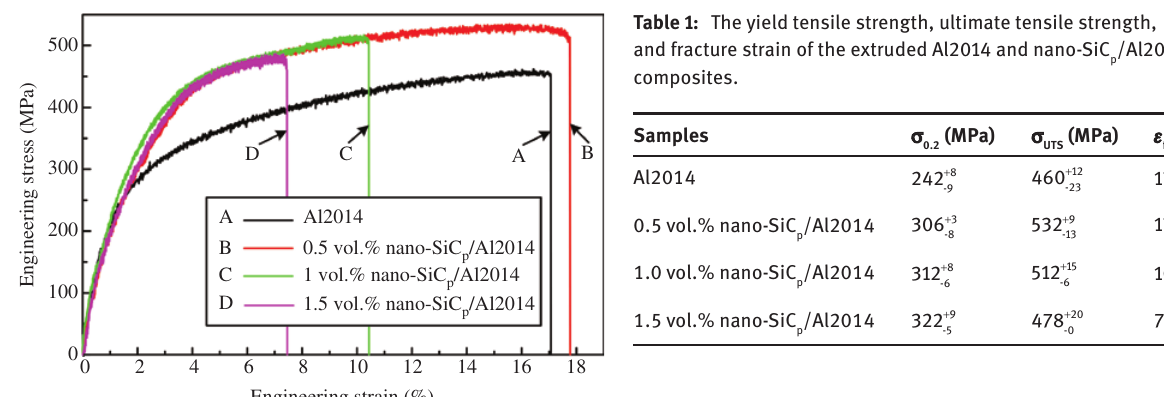
Figure 6: The FESEM micrographs of extruded nano-SiC vol.%, (B) 1 vol.%, and (C) 1.5 vol.%.